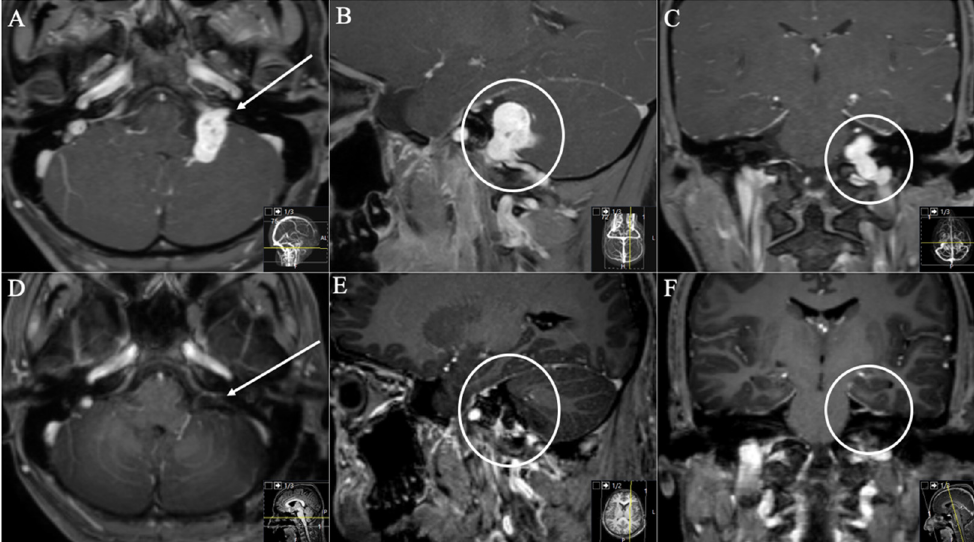
Figure 4. A 26-year-old male patient presented with progressive hoarseness, dysphagia, and extinguished gag reflex. ( A ) Preoperative axial (arrow), ( B ) sagittal (circle), and ( C ) coronal (circle) T1-weighted gadolinium-enhanced MRI, showing the JFS with intracranial extension (Samii Type B). ( D ) Postoperative axial, ( E ) sagittal, and ( F ) coronal MRI control, indicating complete resection through a dorsolateral ELITE approach. Postoperatively, no new deficits occurred. He suffered from postoperative temporary vertigo; hoarseness showed slight improvement during follow-up.